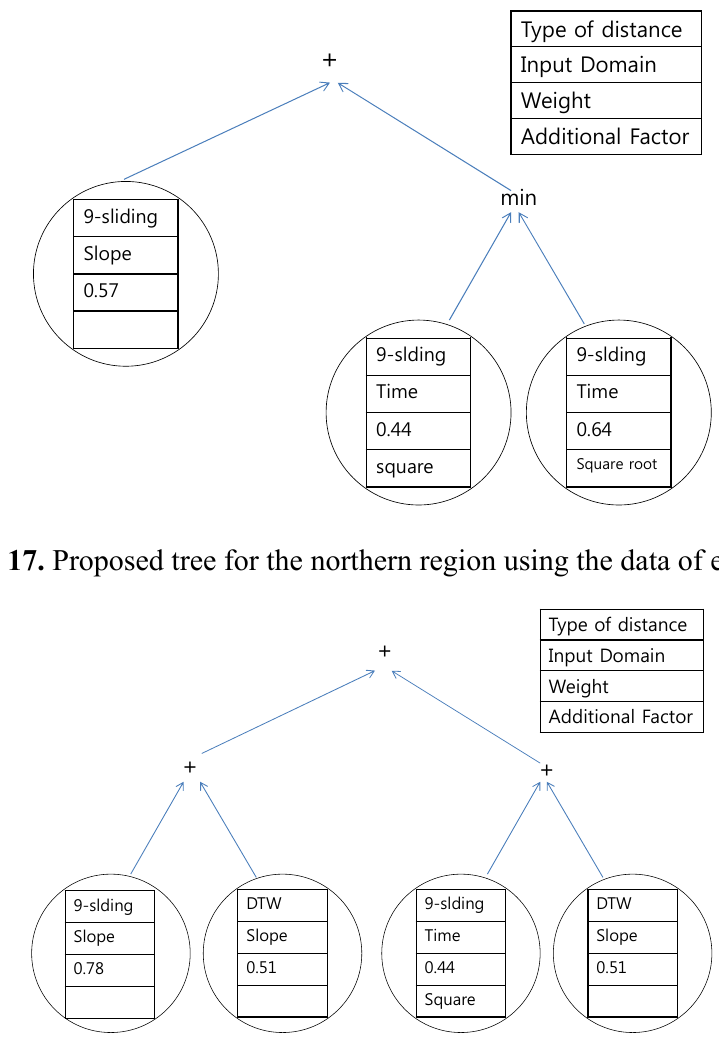
Figure 18. Proposed tree for the northern region using the data of expert